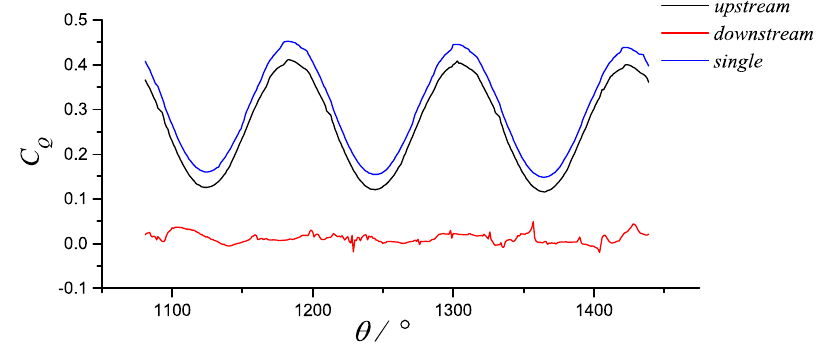
Figure 7. Influence of spacing on turbine moment coefficient where Z = 3 and λ = 2.